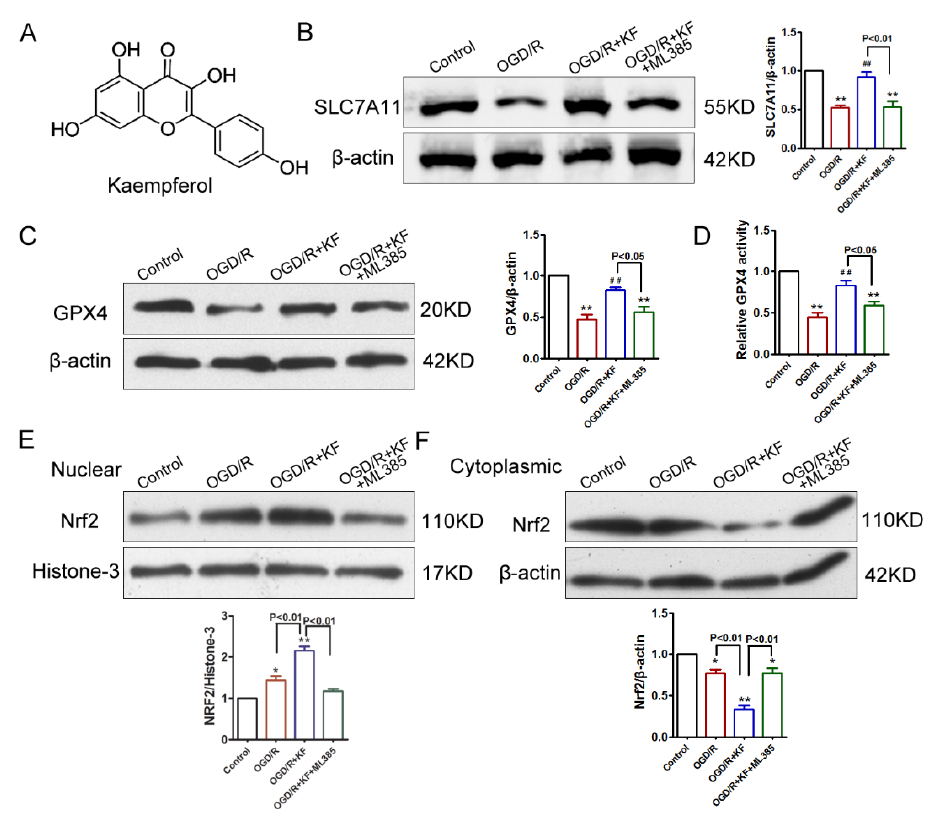
Figure 1. Effects of kaempferol on GPX4, SLC7A11, and Nrf2 levels in OGD/R-treated neurons. ( A ) Chemical structure of kaempferol (KF). ( B ) Neurons were untreated or stimulated with OGD/R, or pretreated with KF (10 µ M) or KF (10 µ M) plus ML385 (1 µ M) for 1 h prior to treatment with OGD/R. Then SLC7A11 protein levels were detected by Western blot. β -actin was used as a loading control. Western blot is representative of three independent experiments. ( C ) GPX4 protein levels were detected by Western blot. ( D ) GPX4 activity was measured. (E) Nuclear Nrf2 protein levels were detected by Western blot. Histone-3 was used as a loading control for nuclear fractions. ( F ) Cytoplasmic Nrf2 protein levels were detected by Western blot. Data were averaged from three independent experiments.* p < 0.05 versus control; ** p < 0.01 versus control; ## p < 0.01 versus OGD/R.